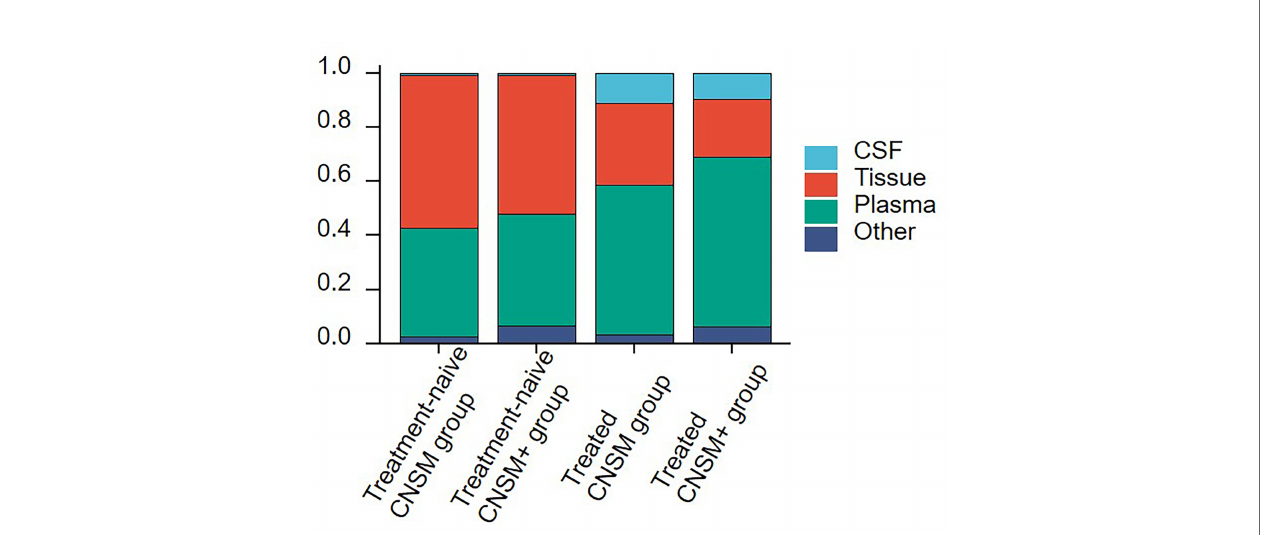
FIGURE 2 | Sample selection for genetic pro fi ling in NSCLC patients with CNS metastases. The 1,396 samples were divided into the following 4 groups according to treatment history and metastasis sites: the treatment-naive CNSM group (n = 117), the treatment-naive CNSM+ group (n = 123), the treated CNSM group (n = 438), and the treated CNSM+ group (n = 718). CNSM group, patients had distant metastases only from the CNS, CNSM+ group, patients with other organ involvement and distant metastases other than CNS